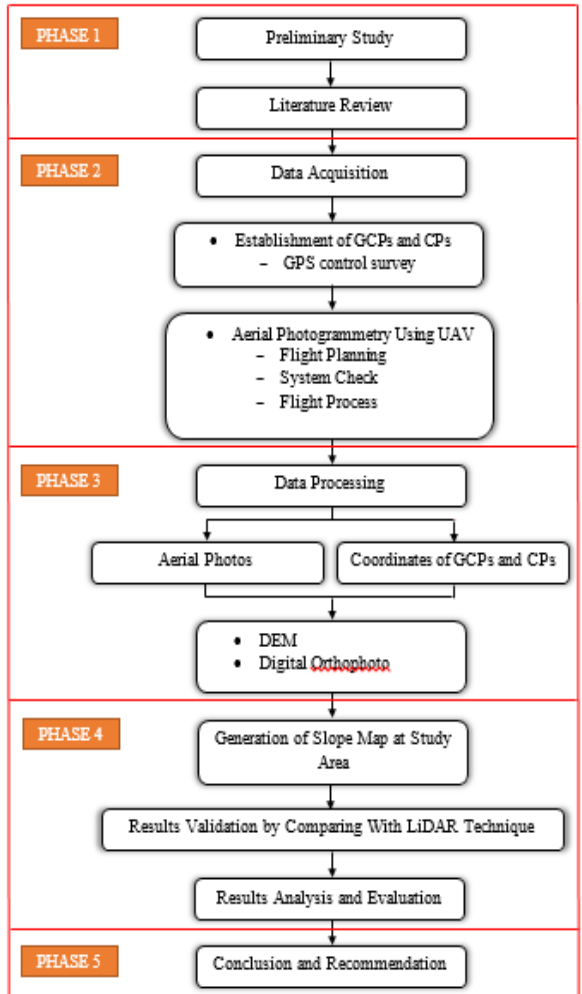
Figure 2. Flowchart of Research Methodology